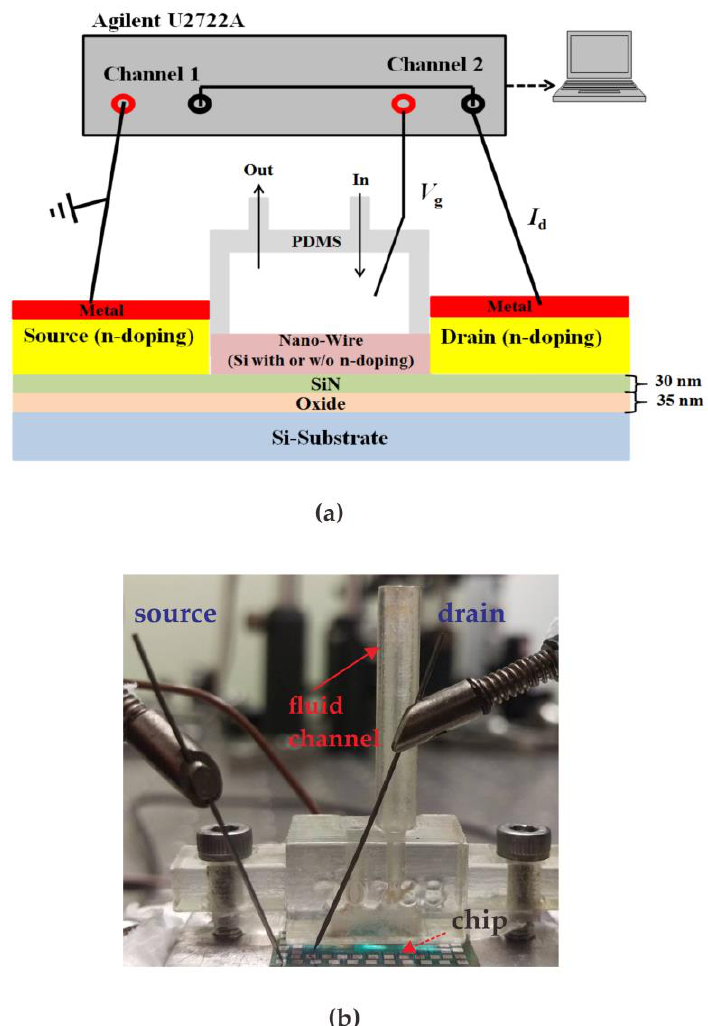
Figure 5. The measurement system of proposed method. ( a ) Diagram of the experimental setup; ( b ) real picture of the measurement system. ( b ) real picture of the measurement